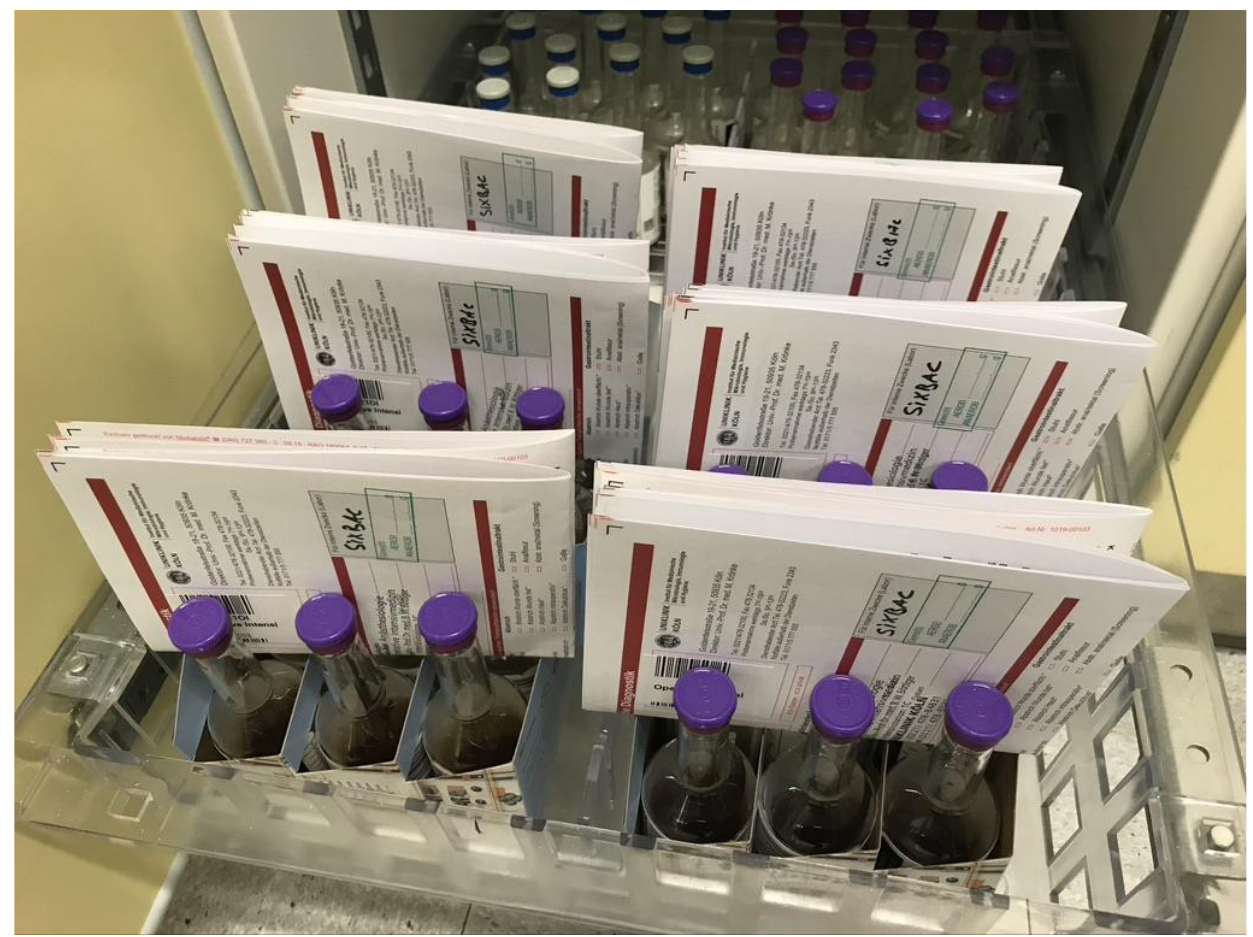
Figure 1. Ready-to- use “six - packs” of blood culture bottles pre -packed in paper crates with pre- filled microbiology lab order forms were implemented in the intensive care unit. On the side of the crates, we placed a sticker with a short summary of the most important points of the new standard operating procedure (SOP). The standard bottles were stored behind in case more than six bottles were needed.